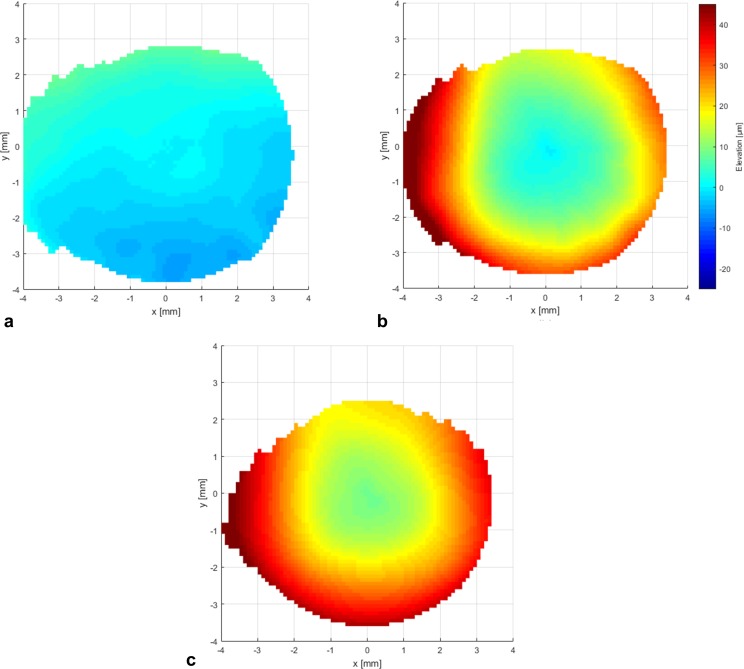
Systematic differences.Systematic differences between the average elevation data maps obtained with Pentacam AXL and CASIA 2 (average elevation obtained with Pentacam AXL minus average elevation with CASIA 2). (a) The measurements are consistent for the anterior corneal elevation. (b) There were significant systematic differences between the posterior corneal elevation measured with Pentacam AXL and CASIA 2 and (c) between the pachymetry measurements.